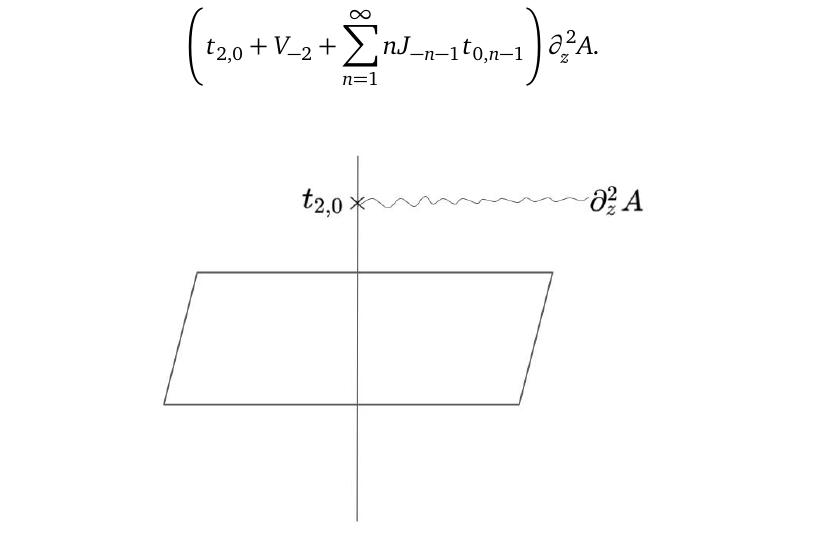
Figure 5: The Feynman diagram associated with the LHS of (25): t